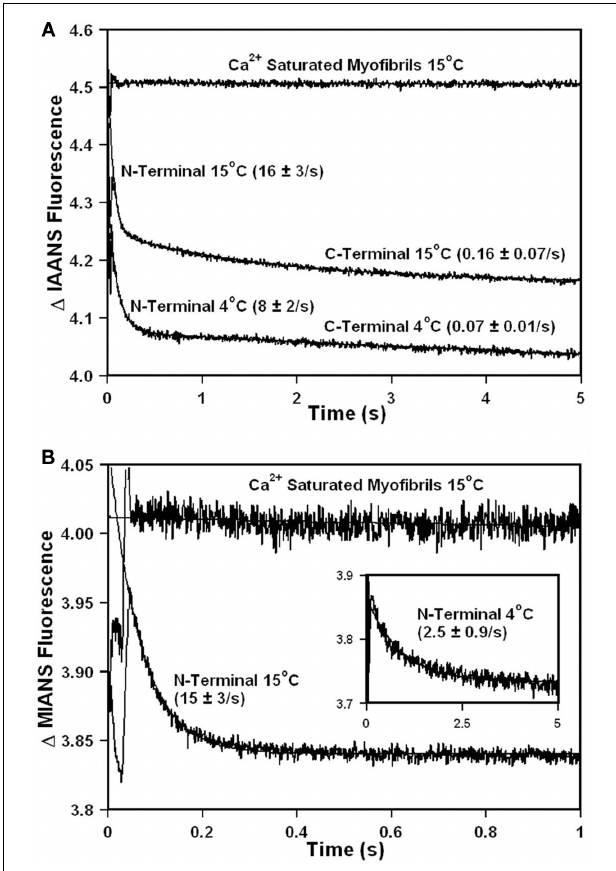
FIGURE 6 | Comparison of calcium dissociation kinetics from TnC T54C,C101S andTnC T54C,C101S reconstituted myofibrils. (A) Shows the time IAANS MIANS course of decrease in IAANS fluorescence as Ca 2 + was removed by EGTA from the N-terminal regulatory and C-terminal structural Ca 2 + -binding sites ofTnC T54C,C101S IAANS